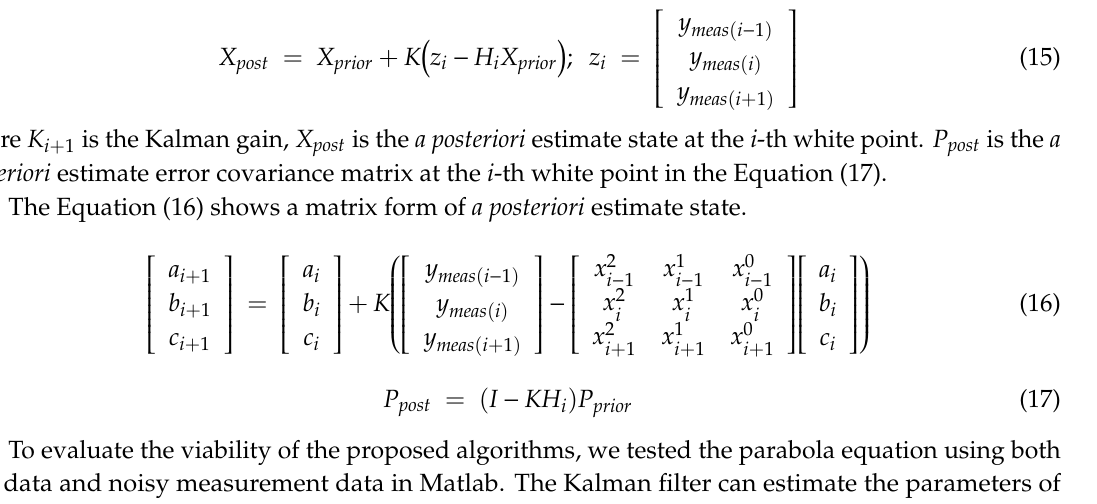
Figure 6. Relationship between “ a ” parameter and road turning.